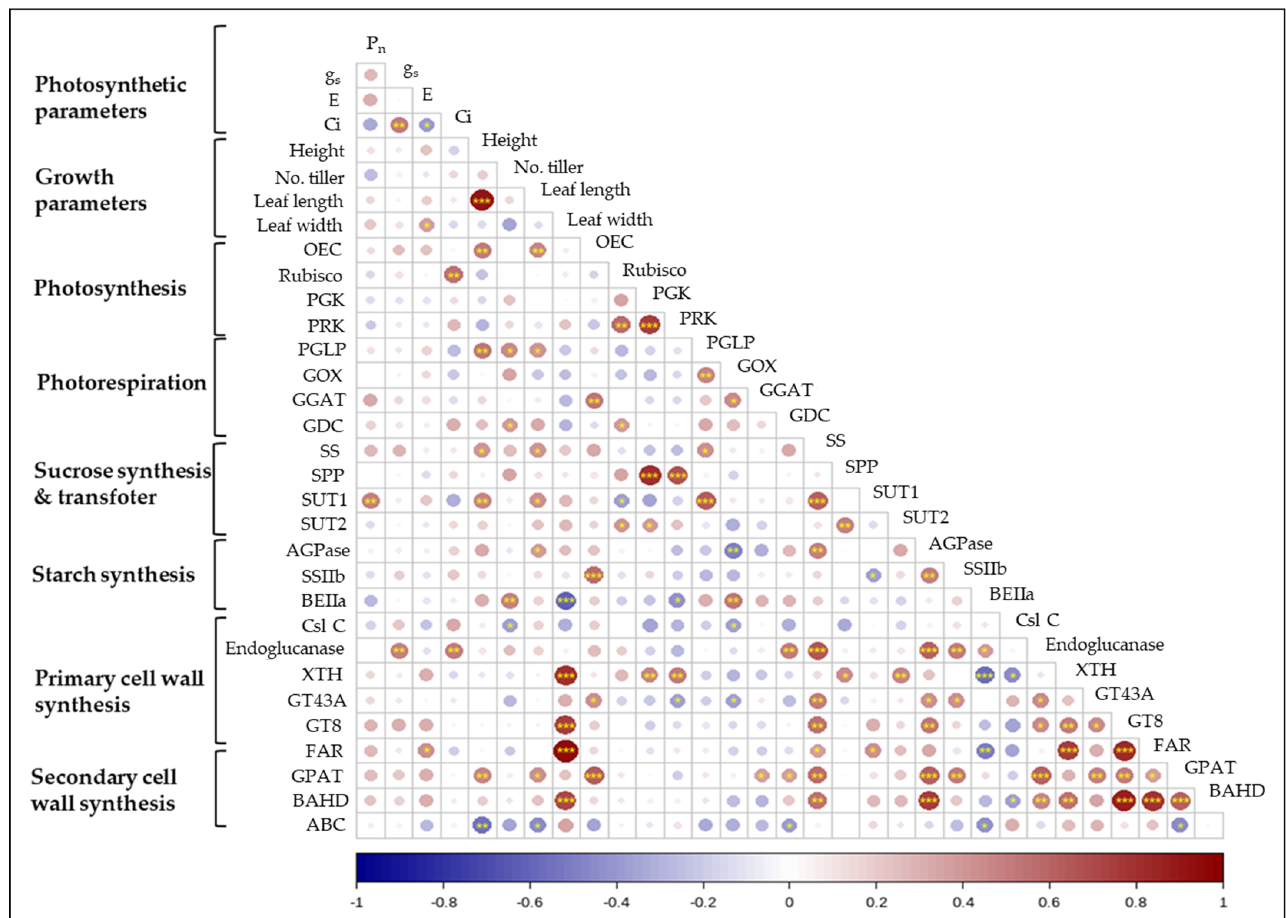
Figure 7. Pearson’s correlation coefficient between genes in 10 Oryza species datasets. Red and blue colors represent positive and negative correlations, respectively. An asterisk, *, **, and ***, indicates the significance at p < 0.05, 0.01, and 0.001, respectively. OEC, oxygen-evolving complex; Rubisco,